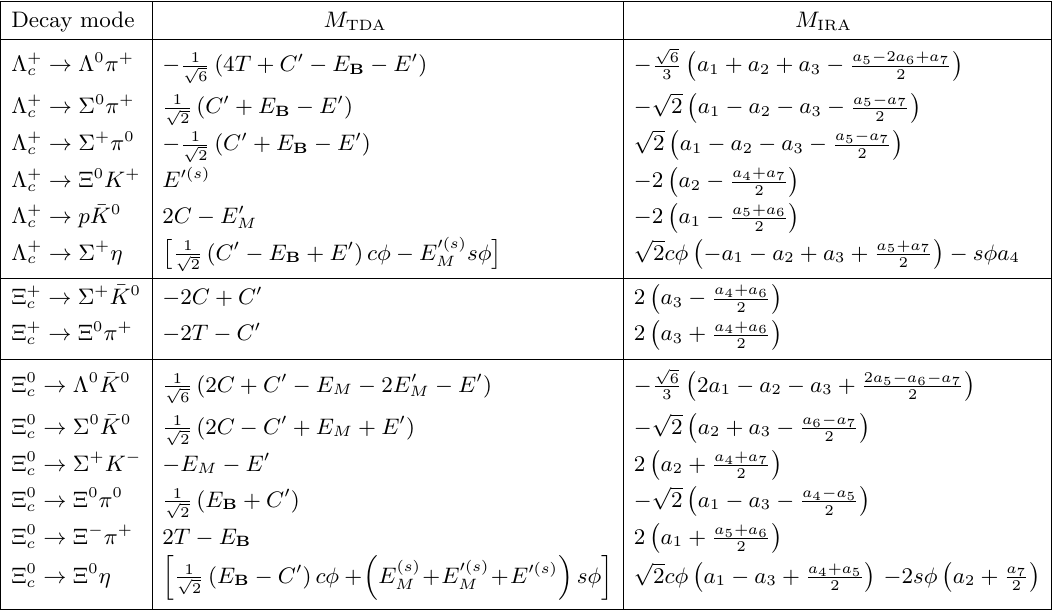
Table 1 . Cabibbo-allowed (CA) amplitudes in the expansions of M TDA and M IRA , and ( sφ, cφ ) ≡ (sin φ, cos φ )